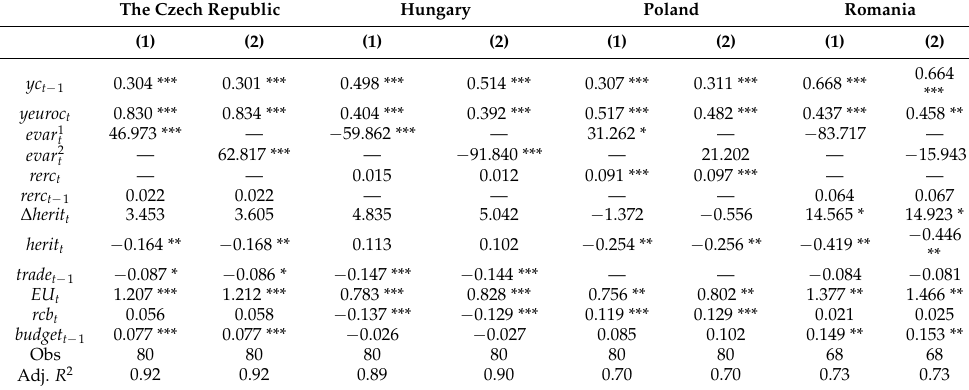
Table 7. Regression results for cyclical components of output (extended model-II).